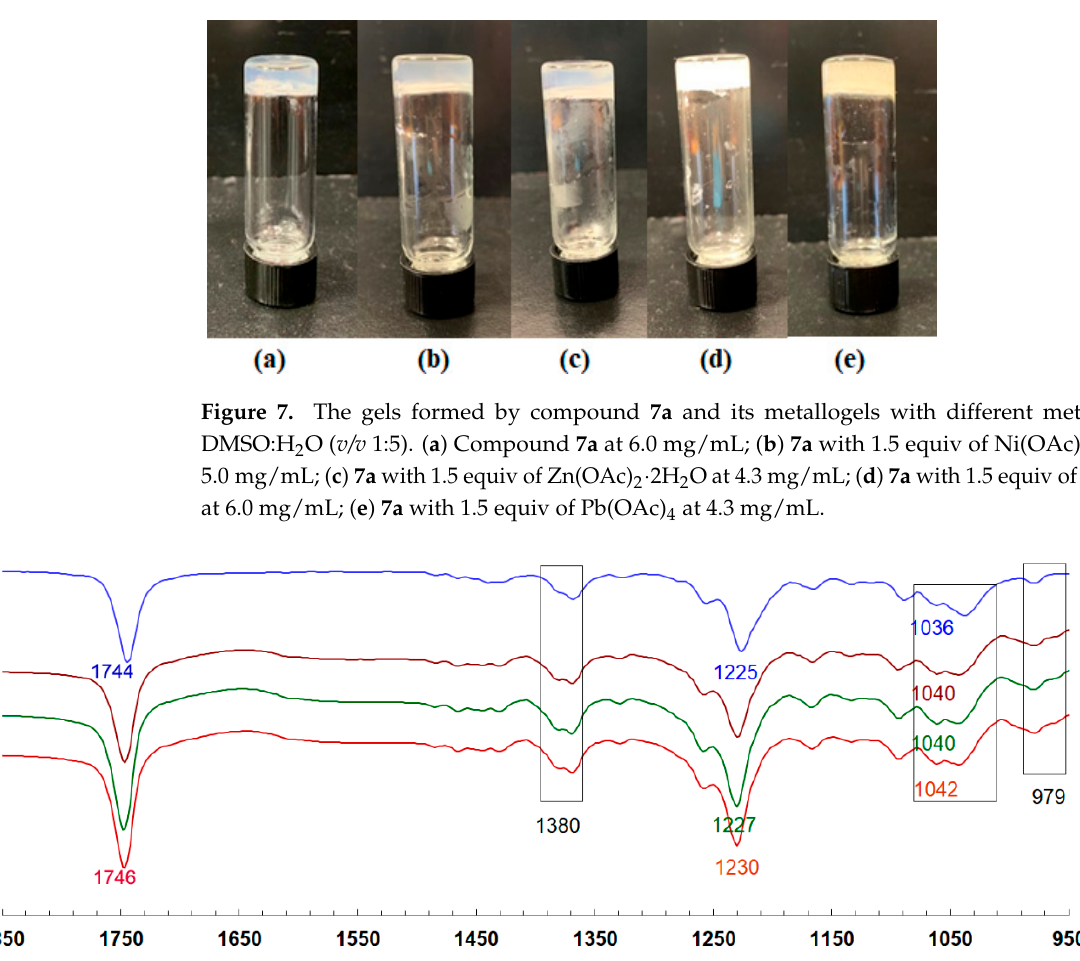
Figure 9. The rheological properties of the gels formed by compound 7a and its metallogels in DMSO:H 2 O (1:5), obtained at 1% strain. The concentrations are 6.0 mg/mL for 7a in all three. 2.1.3. Naproxen Trapping and Release Study The effective gelators were analyzed for potential applications for sustained drug de- livery. For this application, it is necessary for the gelator to be able to form co-gels with the target drug compounds. The phenylacetylene derivative 7a was used as the gelator and naproxen was used as the model drug. Naproxen acid contains aromatic functional group and may interact with the gelators through multiple interactions, therefore, result- ing in co-gelation with compound 7a . We found that naproxen formed stable co-gels with